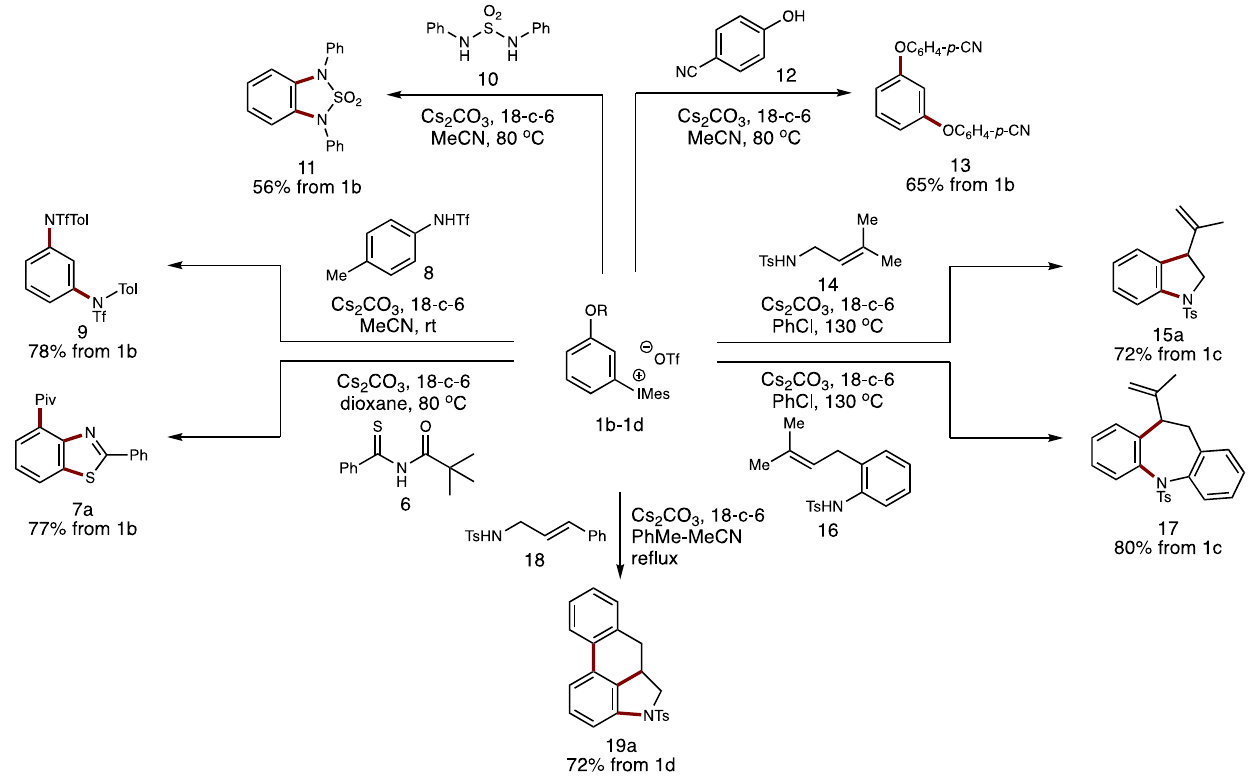
Fig. 4 | Study on domino aryne reactions with 1b-1d. All reactions are performed on a 0.2mmol scale. Isolated yields are